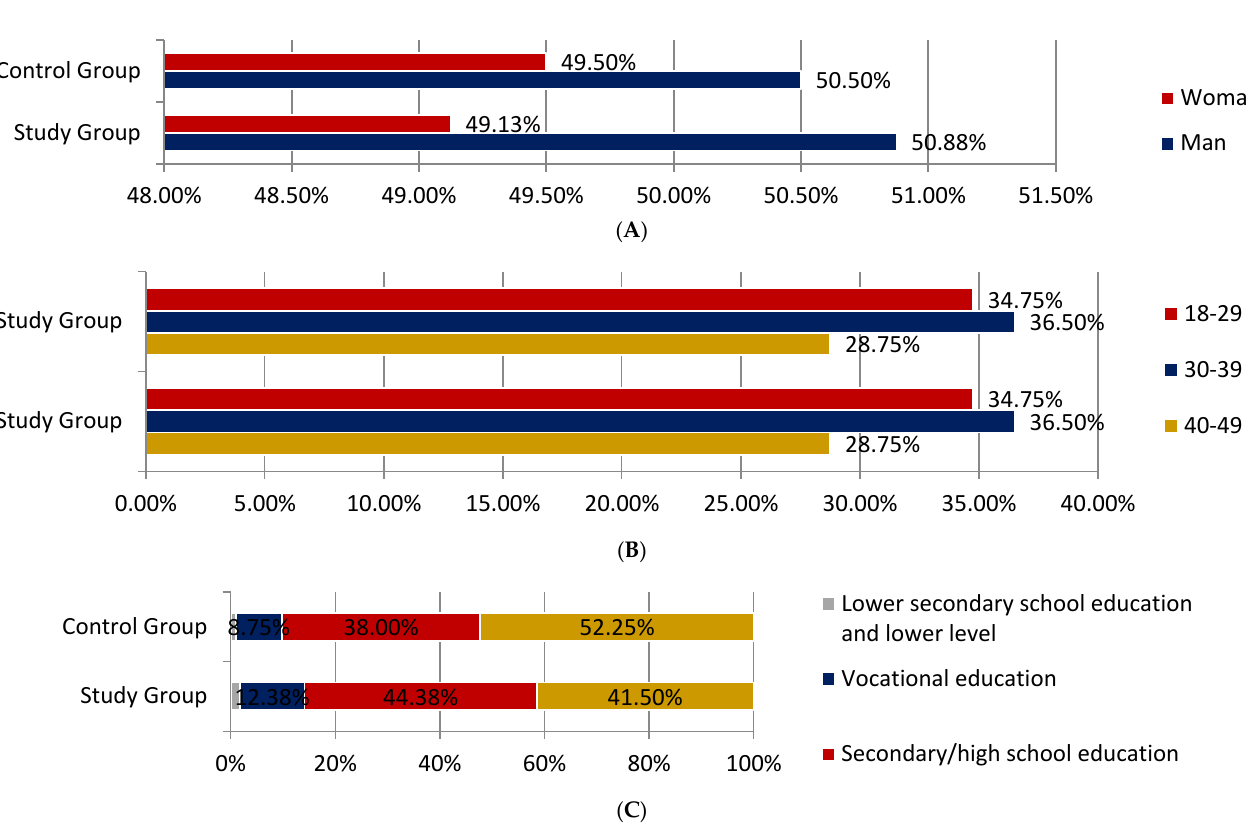
Figure 1. ( A ) Gender of respondents. ( B ) Age of respondents. ( C ) The level of education. Arterial hypertension was the most commonly declared chronic disease. This answer was provided by almost one in every three individuals (34.42%). Coronary artery disease, heart failure, and other diseases affected fewer patients (3.25%, 8.25%, and 2.00%, respectively). A detailed distribution of responses has been summarized in Figure 2. The respondents who declared that they were not suffering from a chronic disease should be understood as the control group (33.33%).